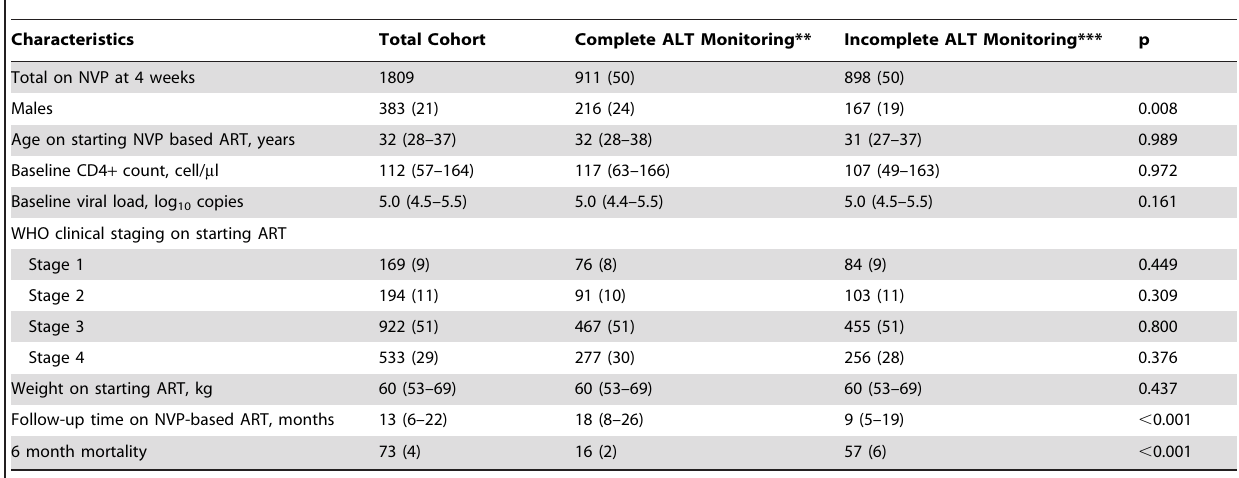
Table 1. Characteristics of patients on nevirapine-based antiretroviral treatment*.